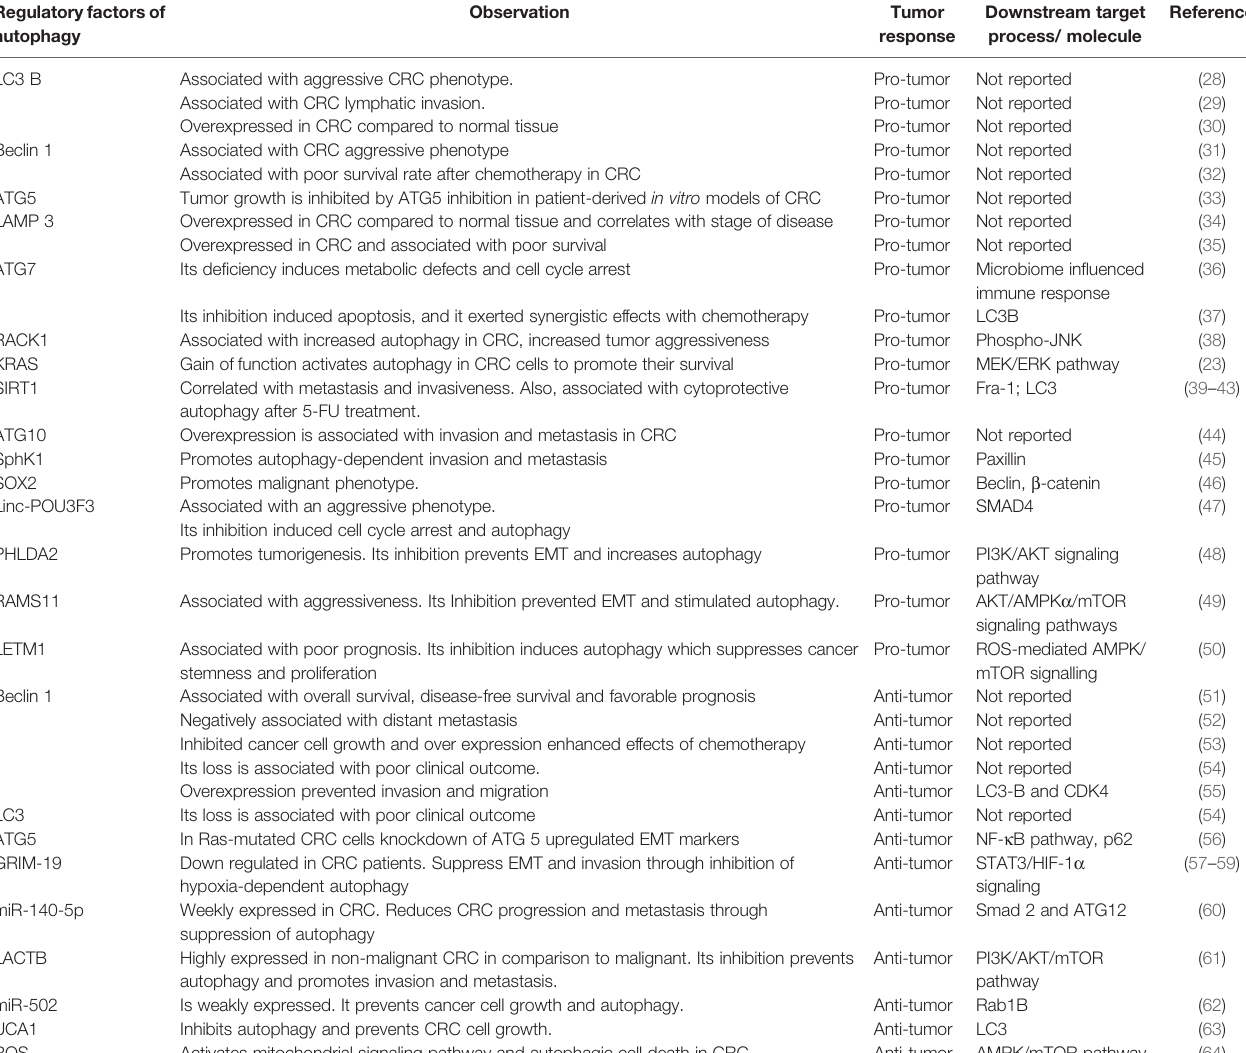
Observation Tumor